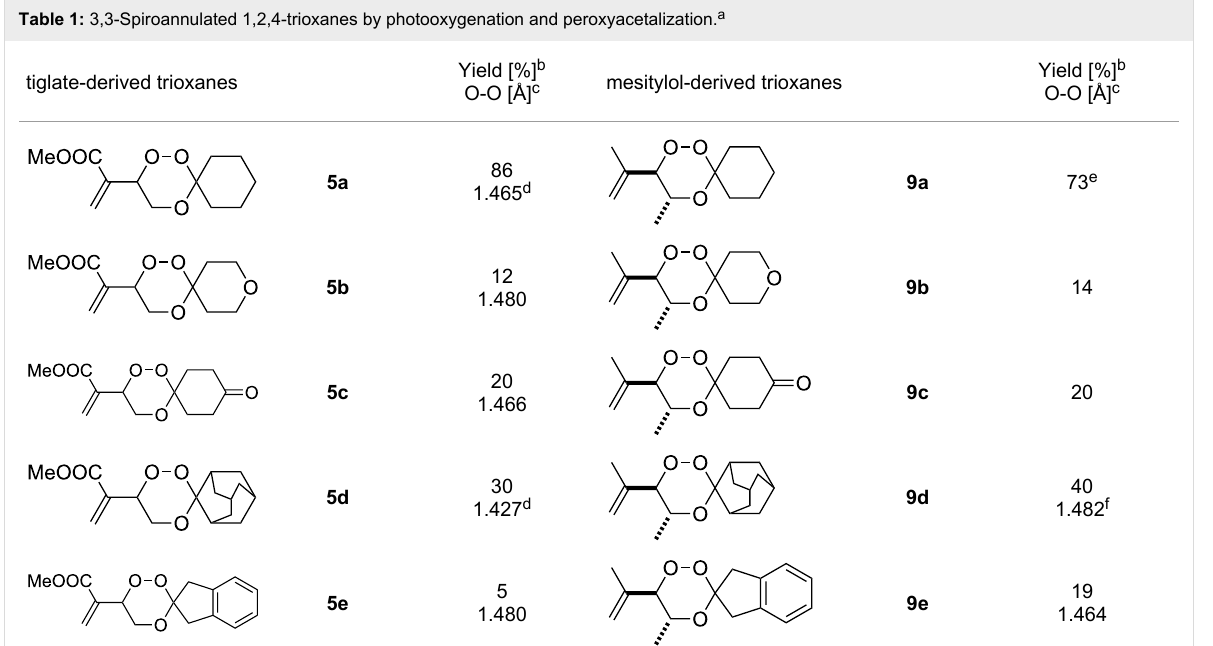
Table 1: 3,3-Spiroannulated 1,2,4-trioxanes by photooxygenation and peroxyacetalization. a